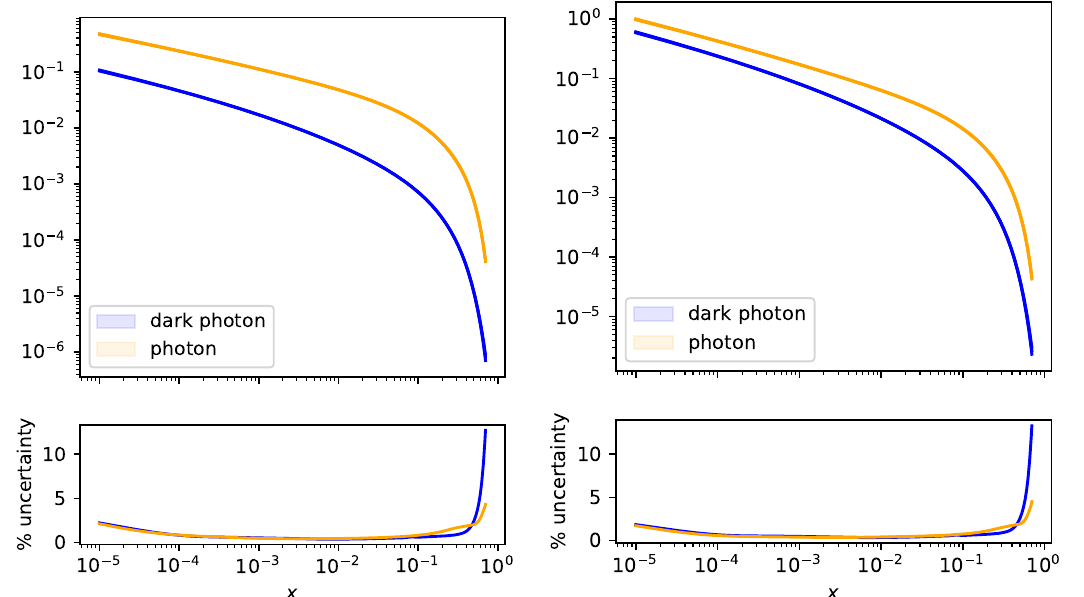
Figure 2 . Comparison of xγ ( x, Q 2 ) and xB ( x, Q 2 ) at Q = 100 GeV (left) and Q = 1 TeV (right) for the values of dark photon mass and coupling given in eq. (2.6). The percentage relative 68% C.L. PDF uncertainties of the photon and the dark photon are displayed in the bottom